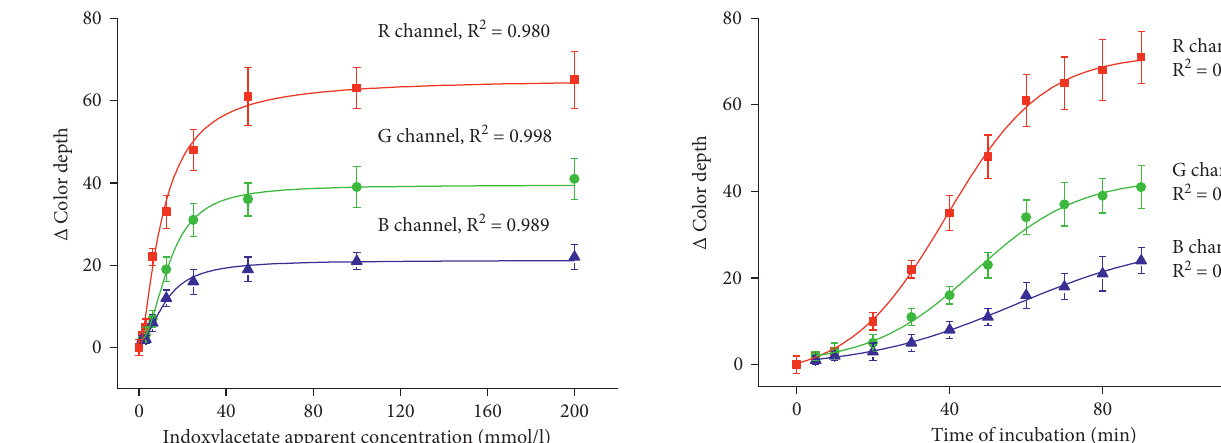
Figure 4: Time of incubation effect on the signal received by colorimetric biosensor performance. The error bars indicate the standard error for five independent repeats ( n �